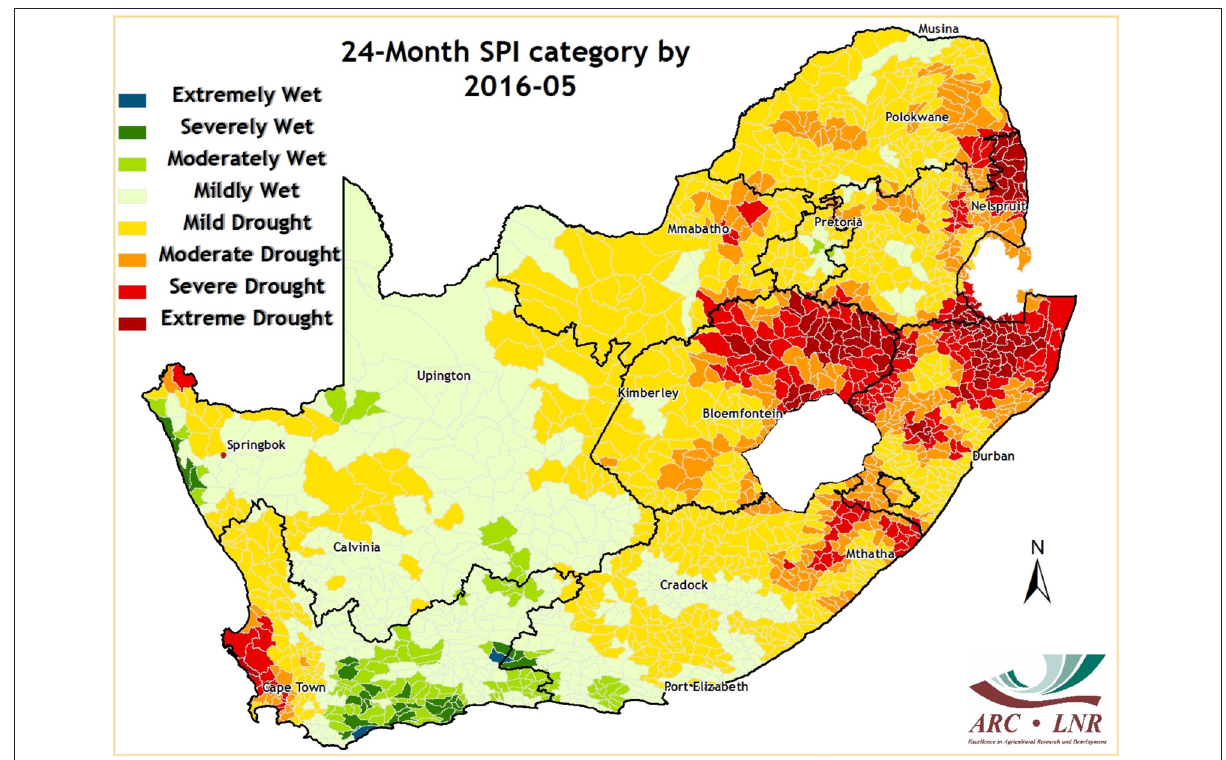
The Standardised Precipitation Index for South Africa over a 2-year period, as of May 2016, indicating which parts of the country experienced the most severe rainfall